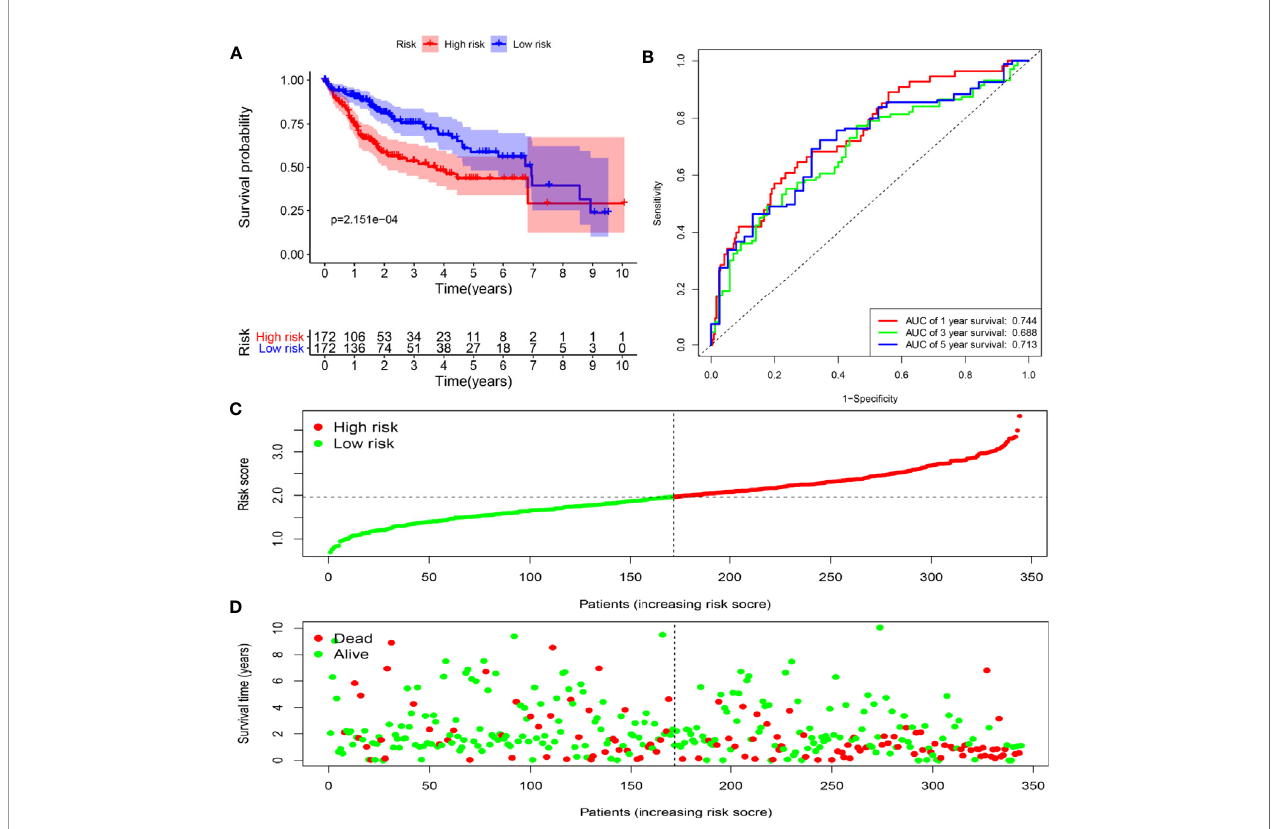
FIGURE 6 | Determination of risk scores by the prognostic model in the TCGA dataset. (A) Survival analysis of high- and low-risk groups. (B) ROC curves analysis of the prognostic model. (C) The risk score distribution of HCC patients. (D) The survival status of patients in the TCGA